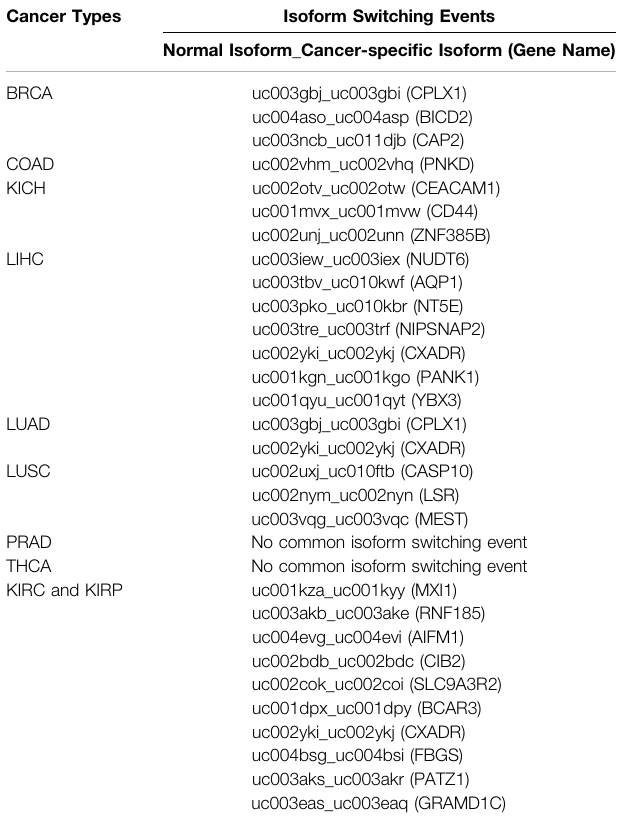
TABLE 2 | Common isoform switching events between the studies of Climente- González et al. , Kahraman et al. and Vitting-Seerup et al. Cancer